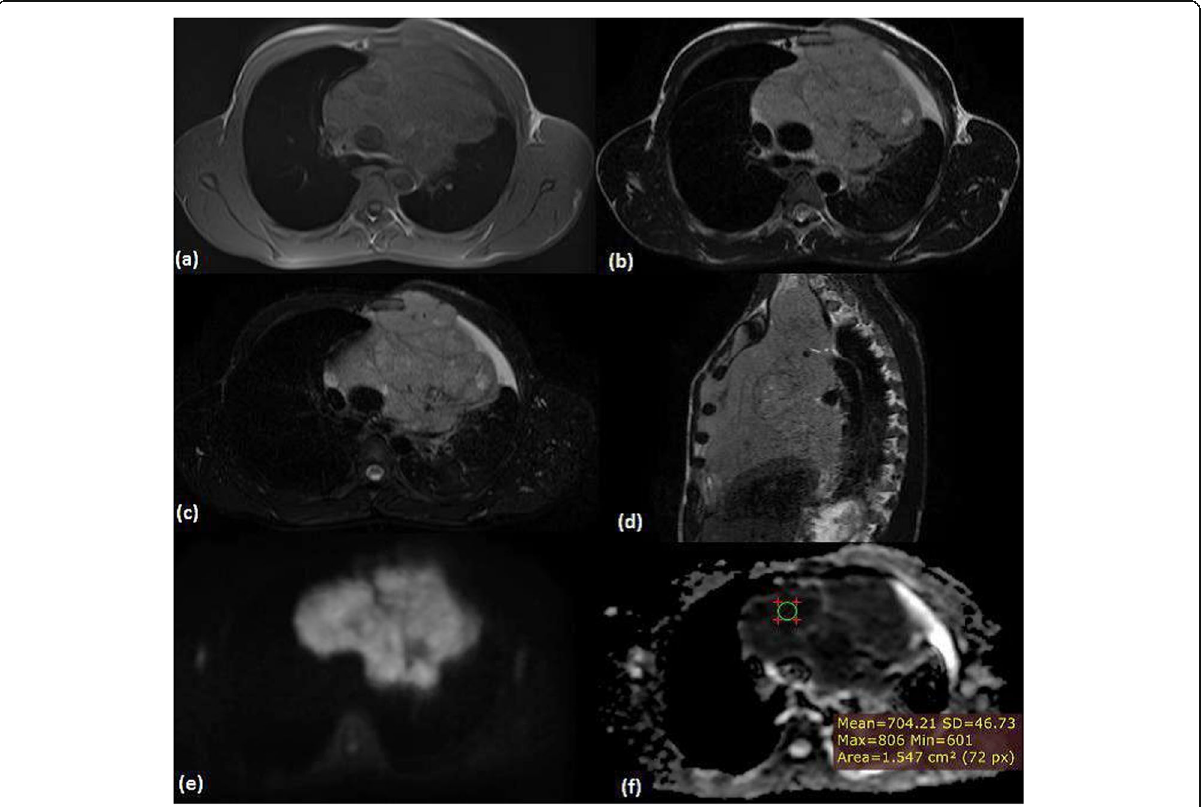
Fig. 3 Seminoma: 30-year-old male with an anterior (prevascular) mediastinal mass identified on CT. The patient clinically presented with dyspnea and chest pain. a Axial T1 WI, b axial T2 WI, c axial STIR WI, and d sagittal T2 WI show a large well-defined macro-lobulated anterior mediastinal mass displaying rather homogeneous intermediate T1, relatively bright T2 and bright STIR signal intensities. The mass shows restricted diffusion; with the predominant bright areas on the e DWI corresponding to dark areas on the f ADC map: ADC mean = 0.615 × 10 − 3 mm 2 /s and ADC min = 0.494 × 10 − 3 mm 2 /s